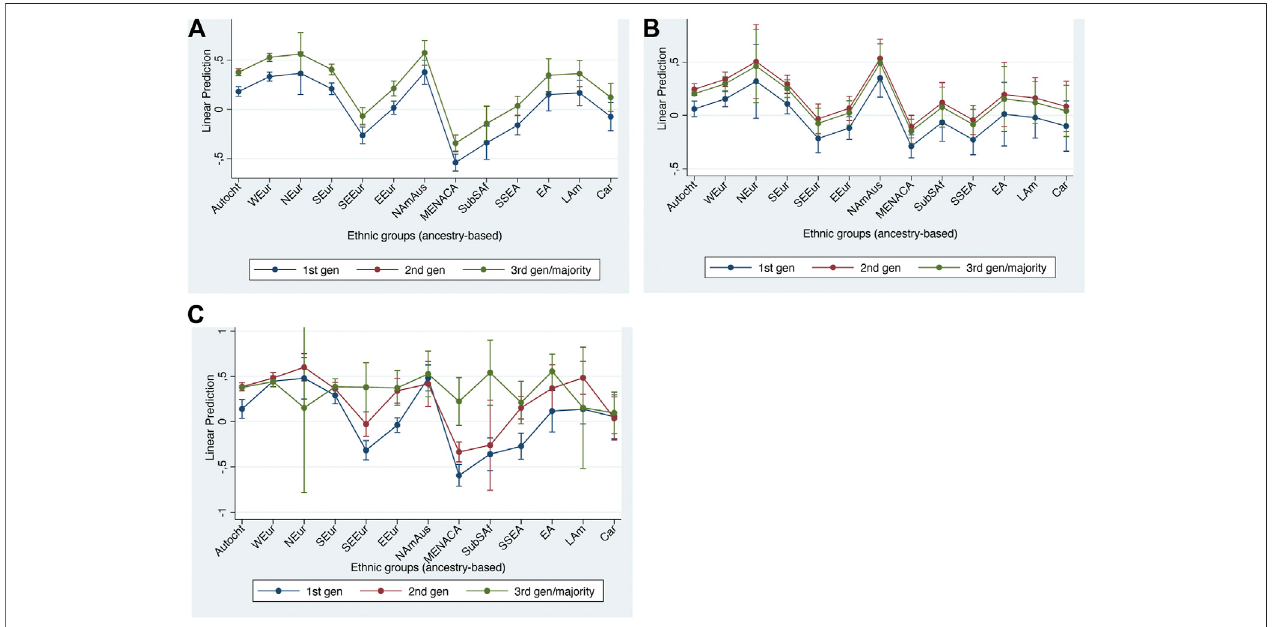
FIGURE 2 | Adjusted predictions at representative values for cultural integration indicators with 95% con fi dence intervals. (A) non-homophobic attitude (main effects model); (B) gender egalitarianism (main effects model); (C) non-homophobic attitude (interaction effects model).